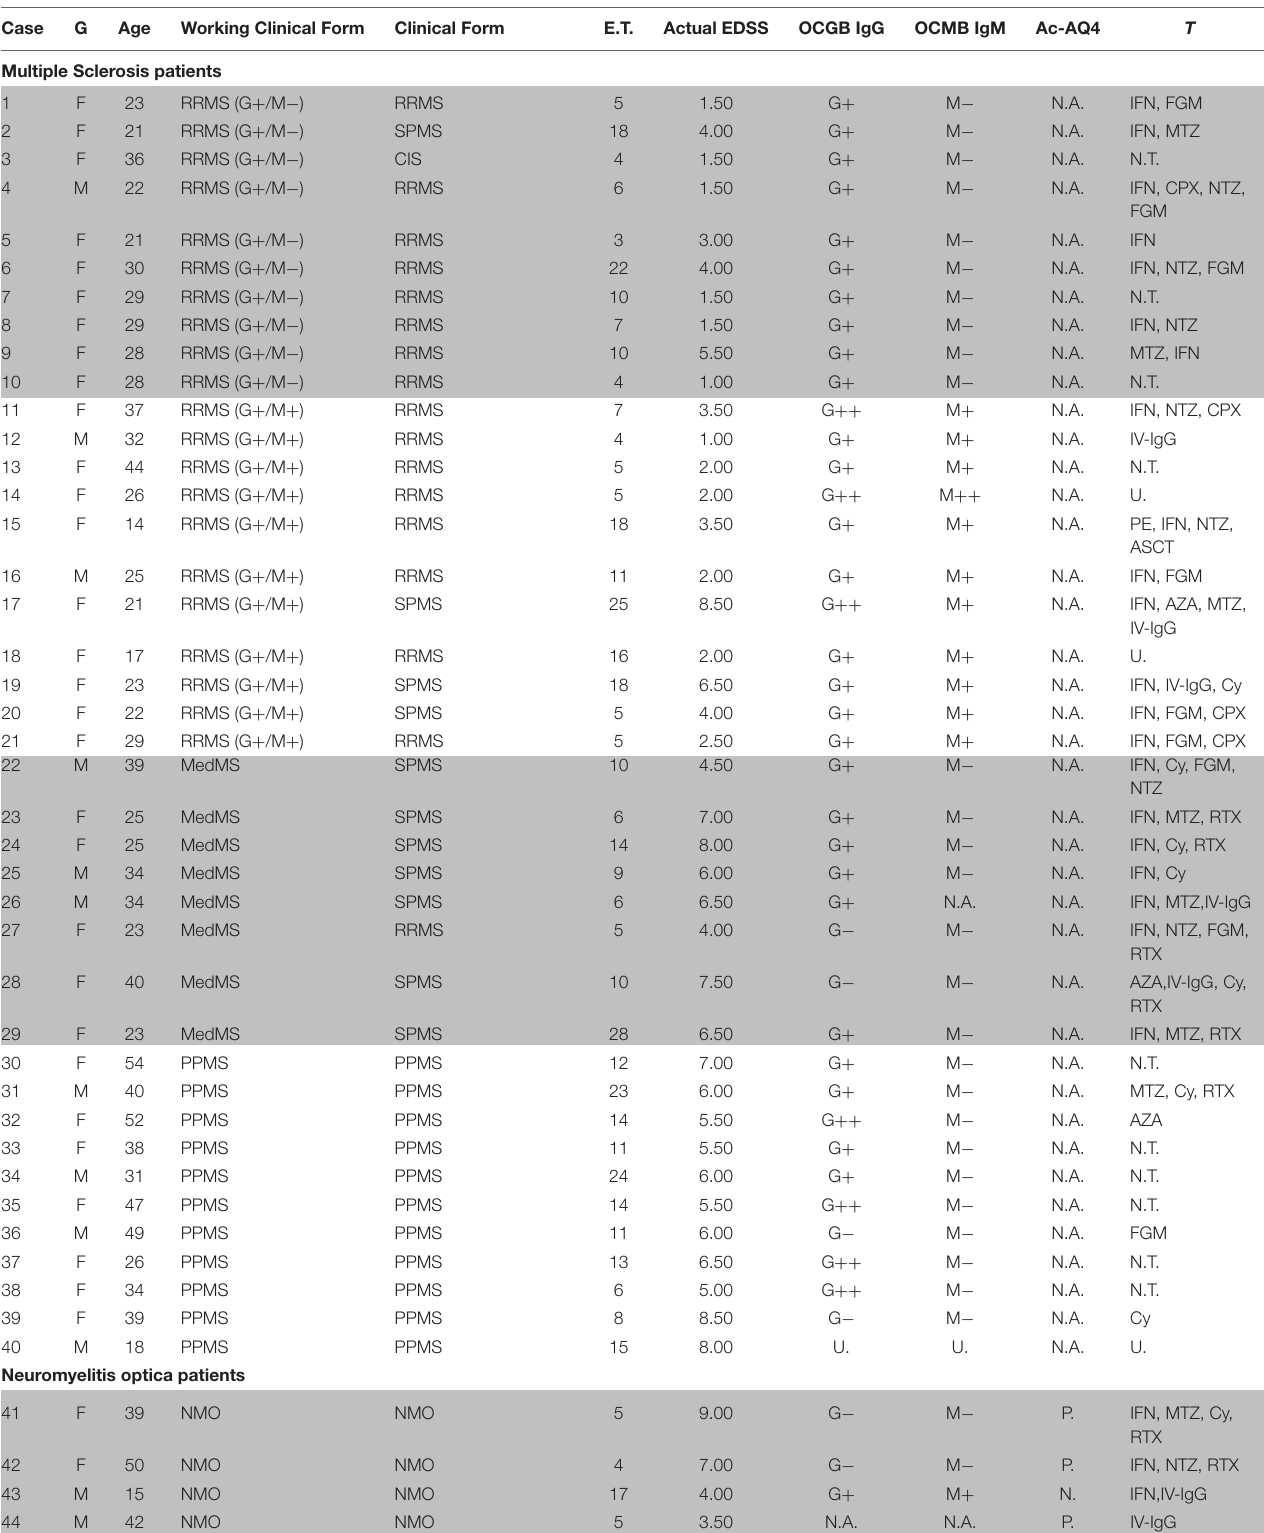
TABLE 1 | Clinical characteristics of the